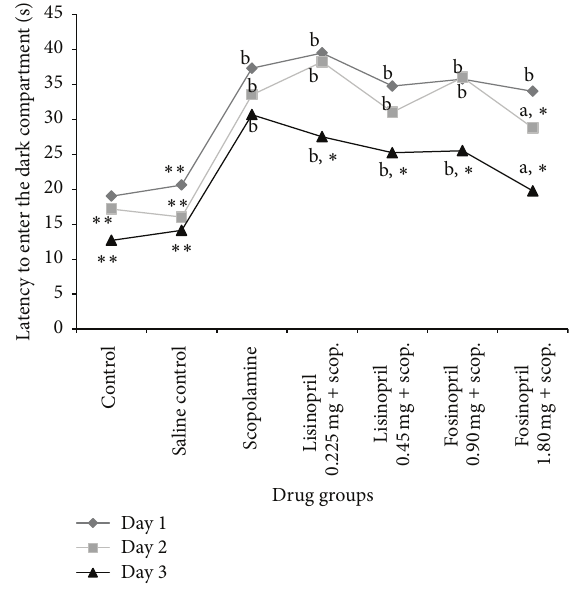
Figure 1: Effect of lisinopril and fosinopril in scopolamine-induced amnesic rats during the exploration trials in passive avoidance test. Comparison between control, scopolamine, lisinopril, and fosinopril during the exploration trials in passive avoidance test. Values are mean ± SE, ∗ versus scopolamine ( 𝑝 < 0.05 ), ∗∗ versus scopolamine ( 𝑝 < 0.001 ), a versus control ( 𝑝 < 0.05 ), and b versus control ( 𝑝 < 0.001